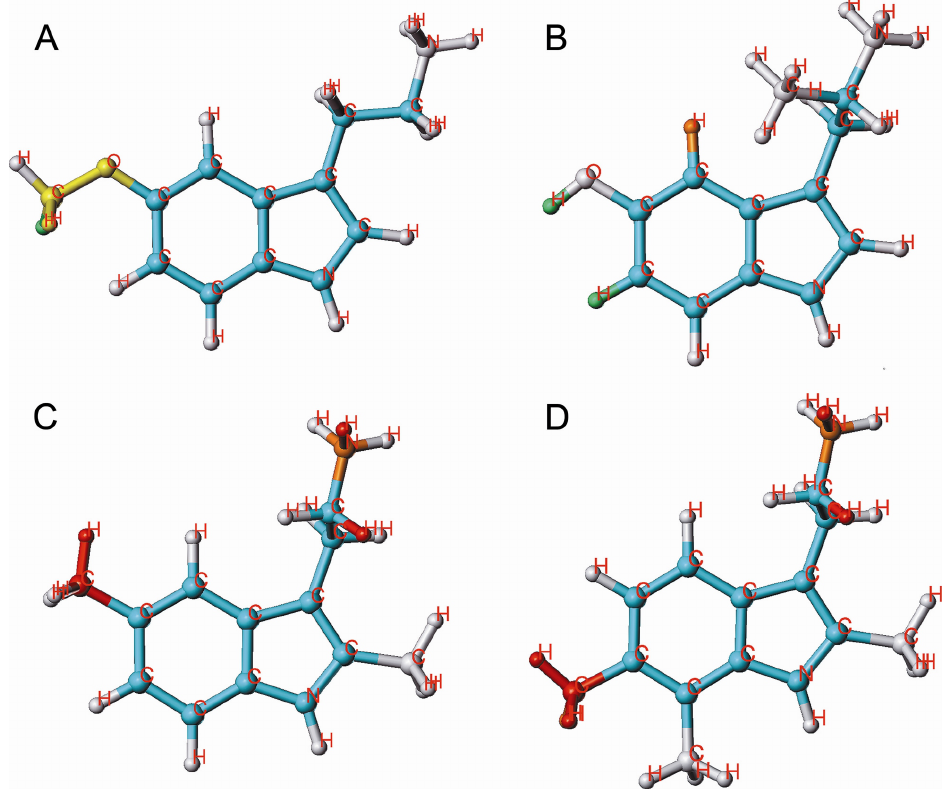
5. HQSAR contribution of molecular fragments to the inhibition of [ 3 H]8-OH-DPAT binding; 2 examples for potent compounds 16 ( A ) and 40 ( B ) and 2 examples for weak compounds 19 ( C ) and 45 ( D ) are